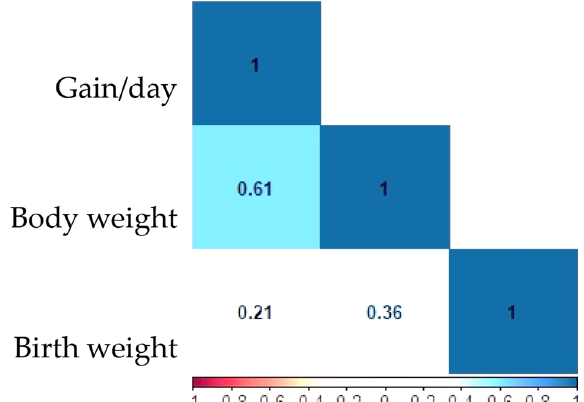
Figure 3. Correlation coefficients among birth weight, daily gain, and body weight in dromedary camels.